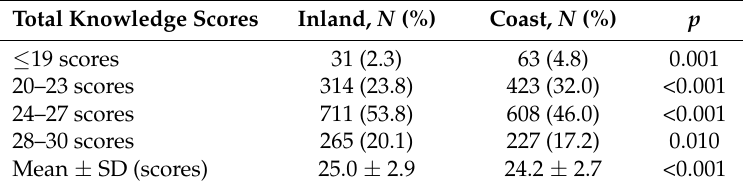
Table 2. Pregnant women’s total knowledge scores according to